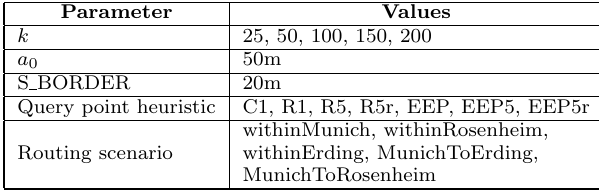
Table 1: Parameter